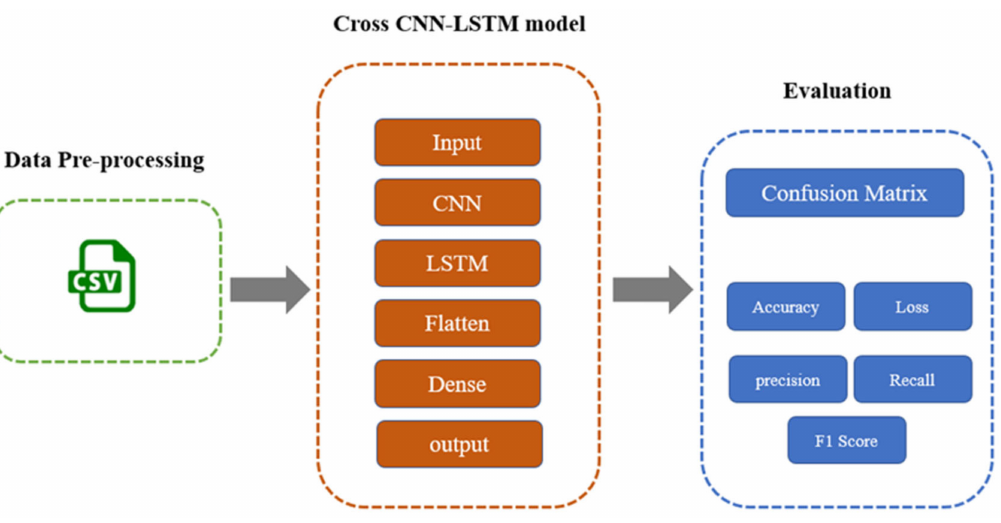
Figure 11. The proposed architecture